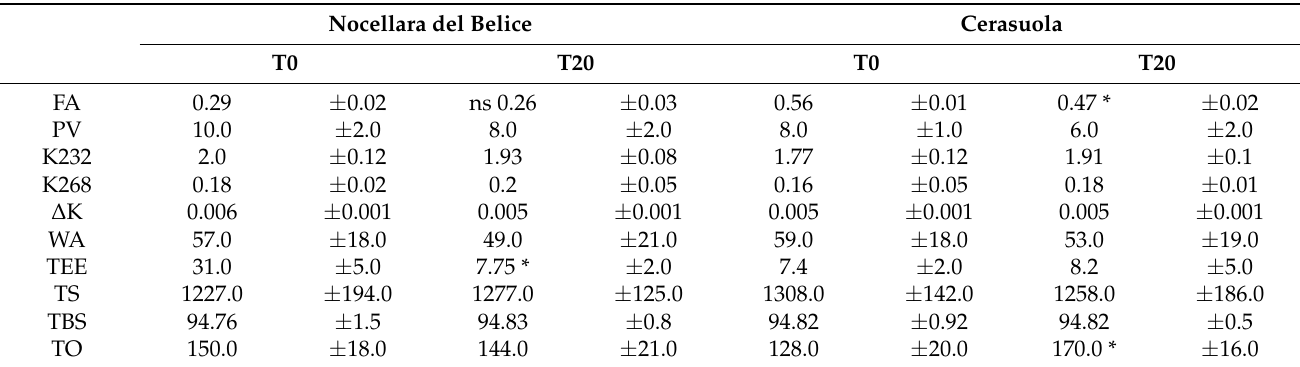
Table 1. Quality parameters (mean ± SD) of Nocellara del Belice and Cerasuola EVOOs for tests T0 (unmodified malaxation) and T20 (modified malaxation, with the application of the SCADA